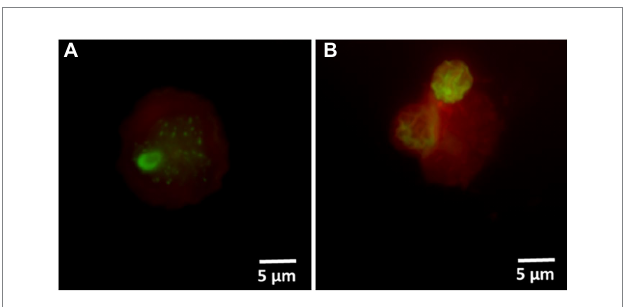
FIGURE 6 FISH of A . polyphaga stained with Alexa Fluor 647 labeled EUK1209 (red) and Legionella stained with Alexa Fluor 488 labeled LEG705 (green) probes. These micrographs show intracellular proliferation of environmental (shower water sample 1: A and sample 2: B ) non- culturable Legionella within A . polyphaga .